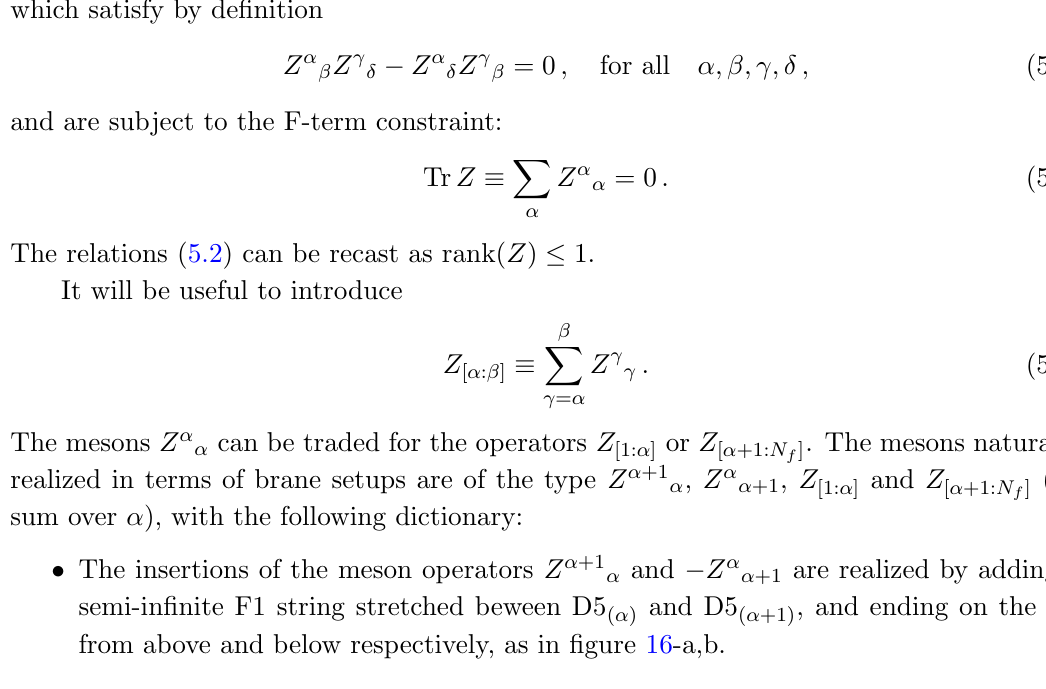
Figure 15 . Quiver and brane con(cid:12)guration of N = 4 SQED. There are N f D5 branes. which satisfy by